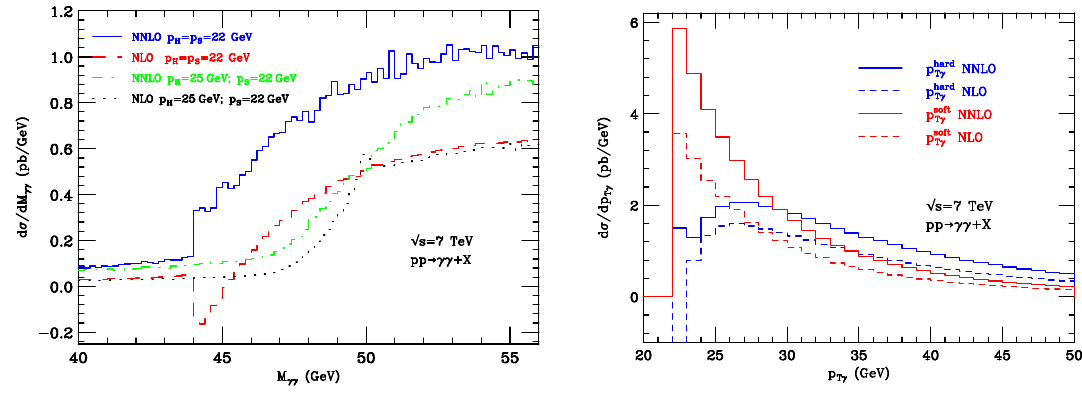
Figure 20 . Left panel: the differential cross section dσ/dM γγ in two configurations with symmetric and asymmetric photon p T cuts. NLO (red dashed) and NNLO (blue solid) results with symmetric cuts ( p H = p S = 22 GeV) and NLO (black dotted) and NNLO (green dash-dotted) results with asymmetric cuts ( p H = 25 GeV, p S = 22 GeV). Right panel: NLO (dashed) and NNLO (solid) results for the differential cross sections dσ/dp hard (blue) and dσ/dp soft (red) of the harder and Tγ Tγ softer photon in the configuration with symmetric p T cuts, p H = p S = 22